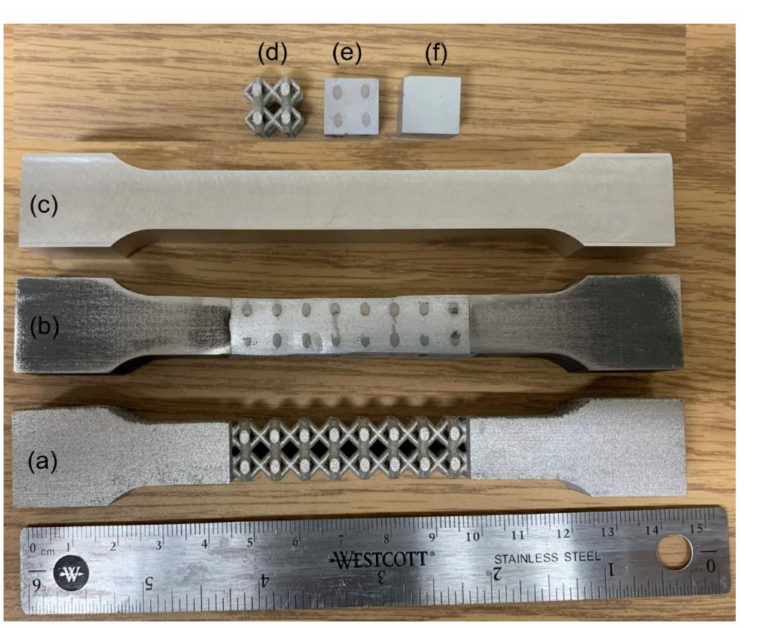
Table 2. The chemical composition of the aluminum alloy used for casting (wt.%). Chemical Composition Fe Value (wt.%) Balance Microstructure analysis for the specimens can be found in Section 2.3 of [67]. An image of all the experimental samples is presented in Figure 3.